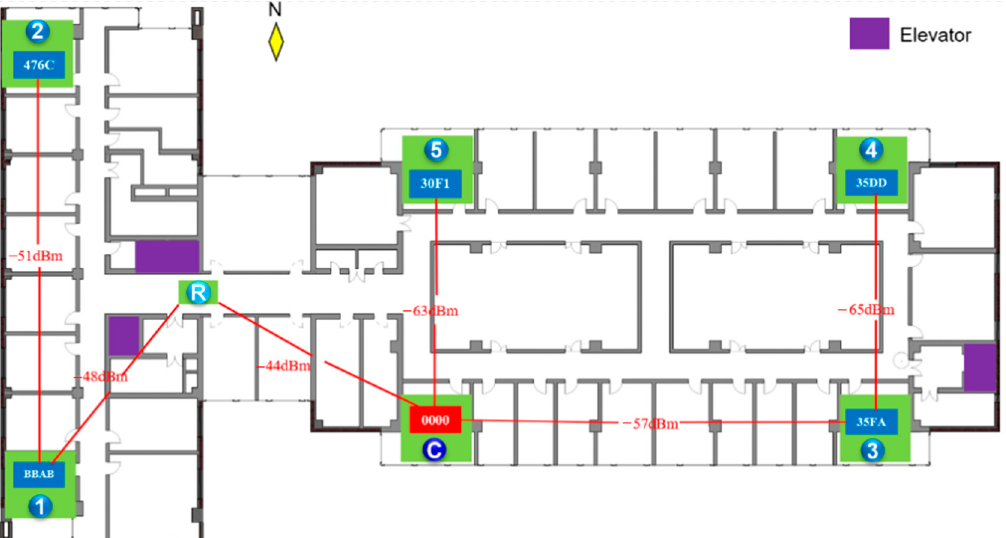
Figure 7. Network topology of horizontal scenario.